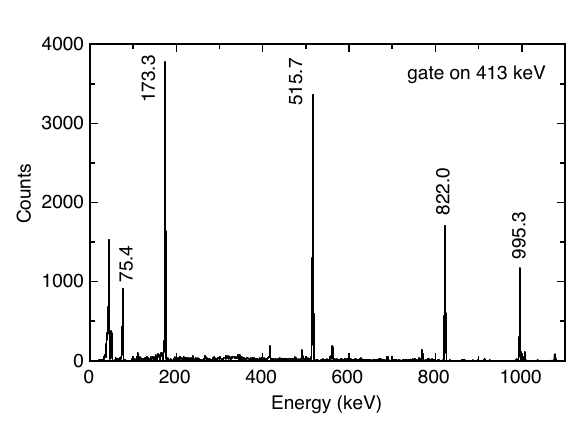
Figure 2. Gamma rays in coincidence with the 413-keV γ ray following the decay of the high-spin, β -decaying state in 160